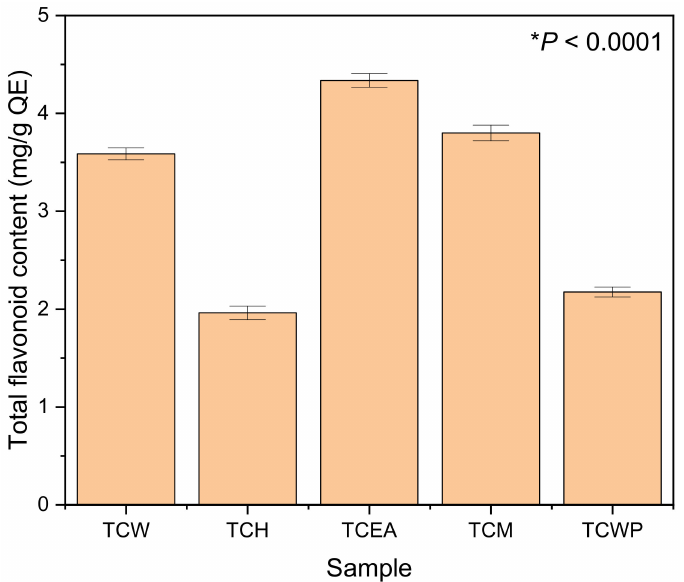
Figure 2. Total flavonoid content of cocoa pod husk extracts. (*) statistically significant at p < 0.05 based on one-way